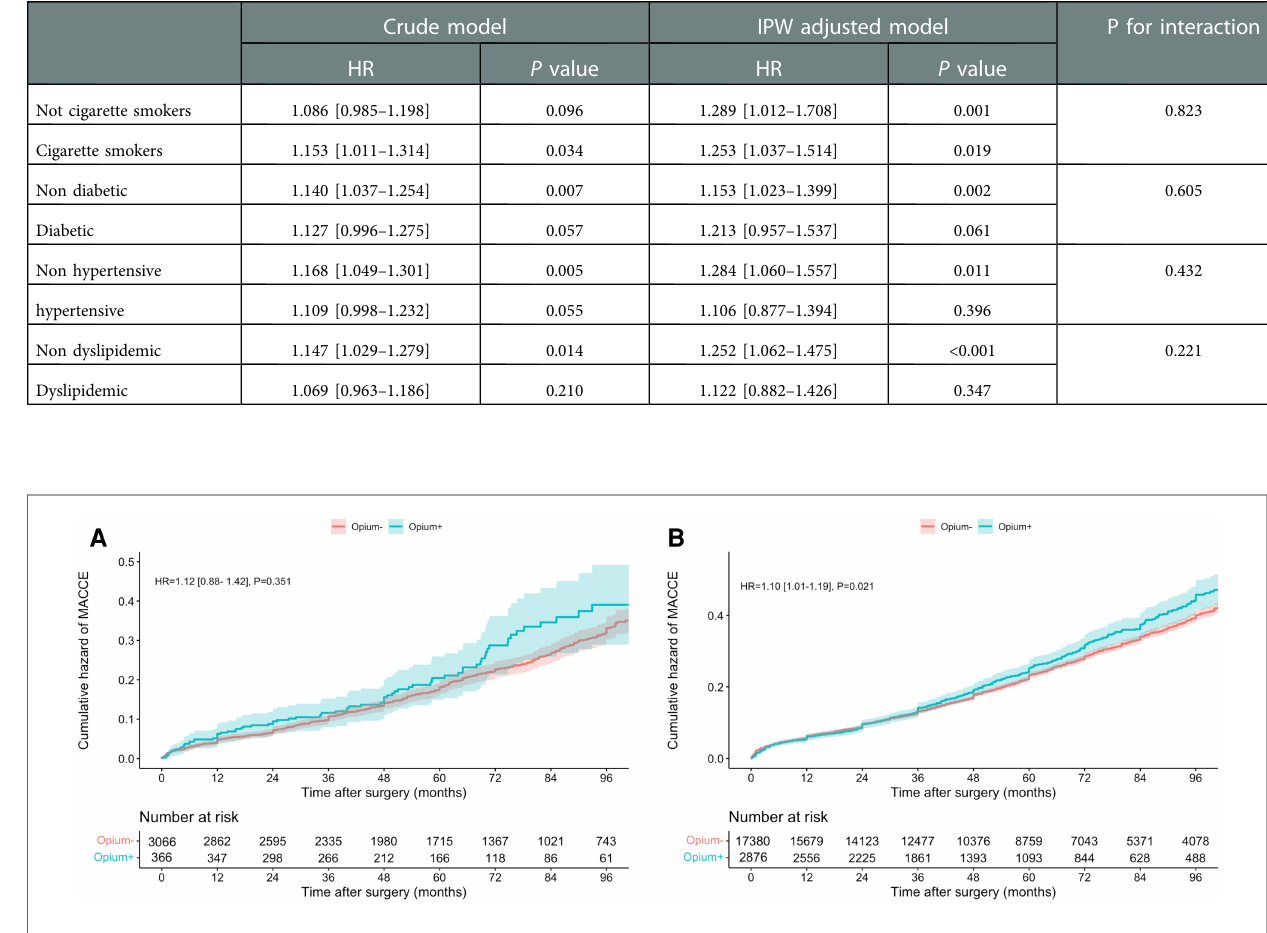
FIGURE 2 Cumulative hazard of MACCE in patients without ( A ) and with ( B ) SMuRF.